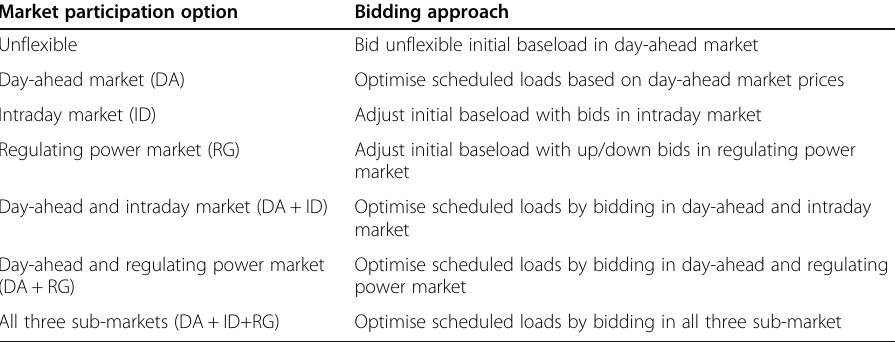
Table 1 Applied market participation